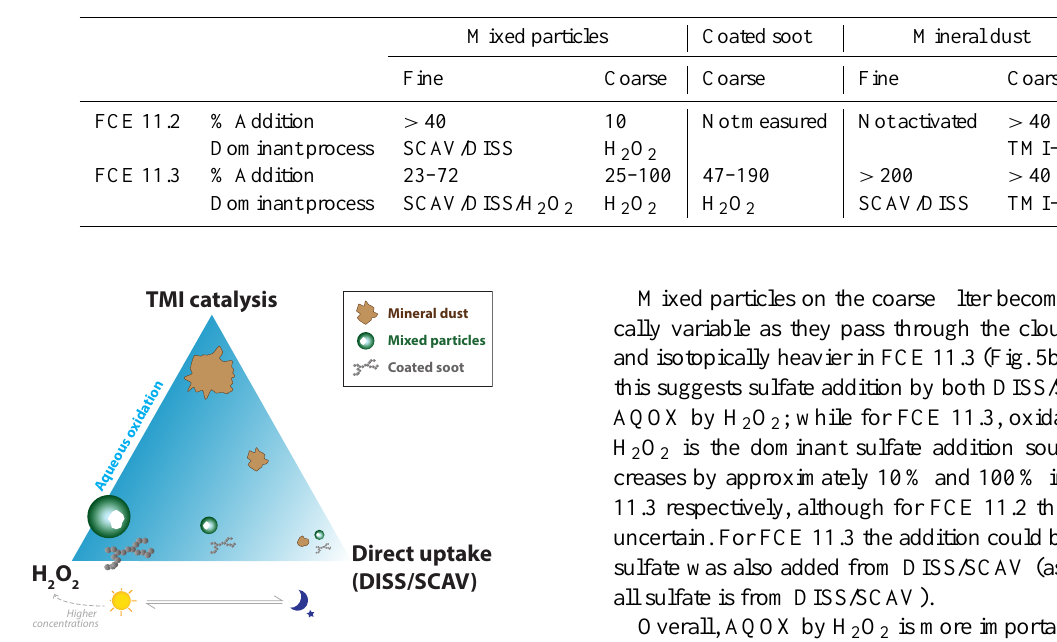
Fig. 6. Schematic summary of the dominant processes contribut- ing sulfate to different particle classes during cloud process- ing at HCCT-2010. Particle size ranges are (approximately) fine, < 600nm, and coarse, >